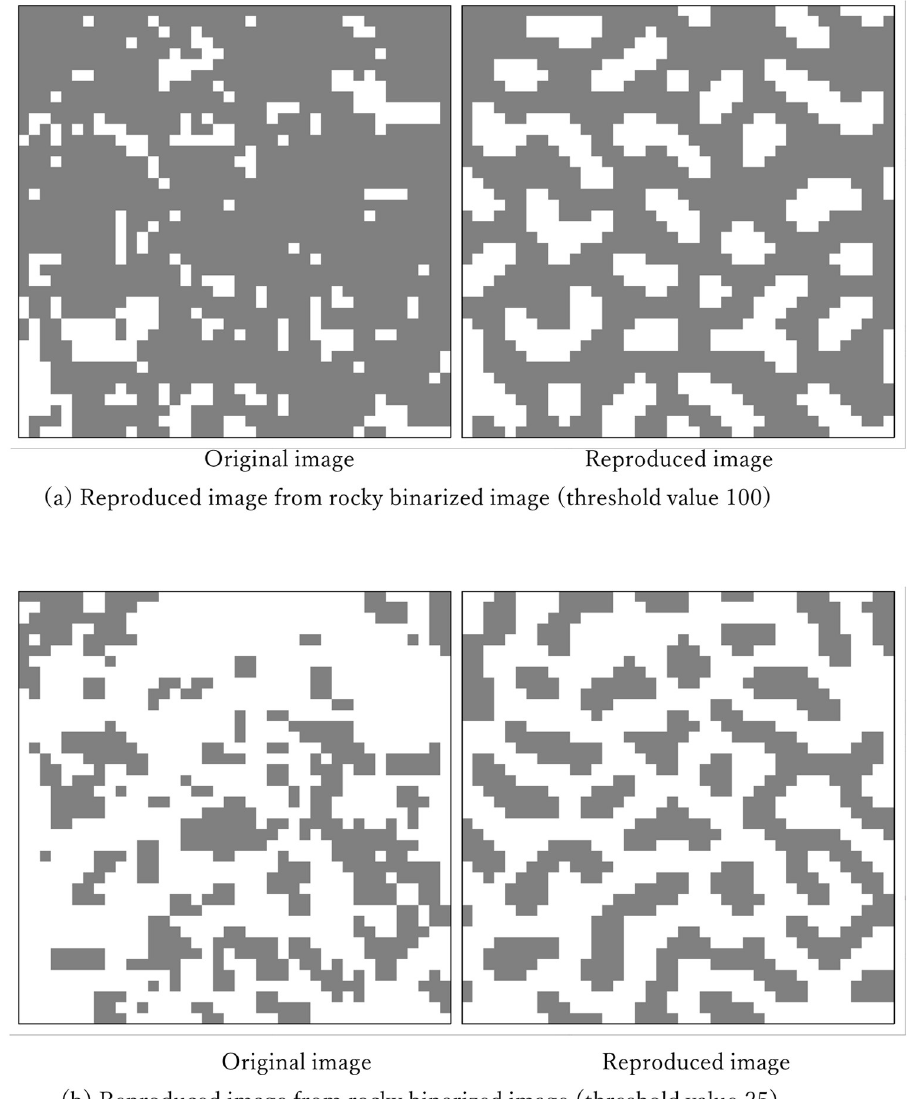
Fig 13. Results of the reproduction of the coastal rocks from binary images using the proposed